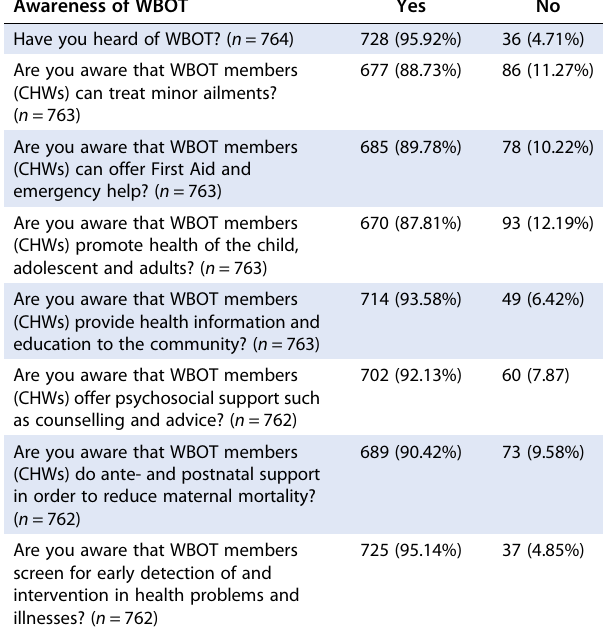
Table 2: Awareness of WBOT Awareness of WBOT